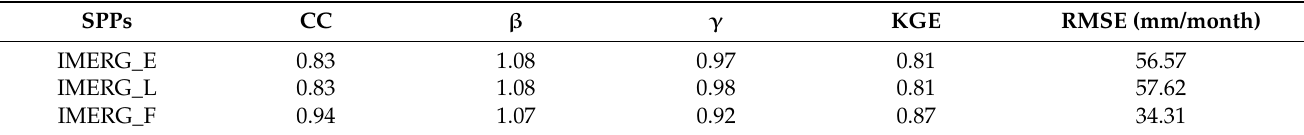
Table 3. Overall performance metrics associated with IMERG products from 2008 to 2017 at monthly level across China.